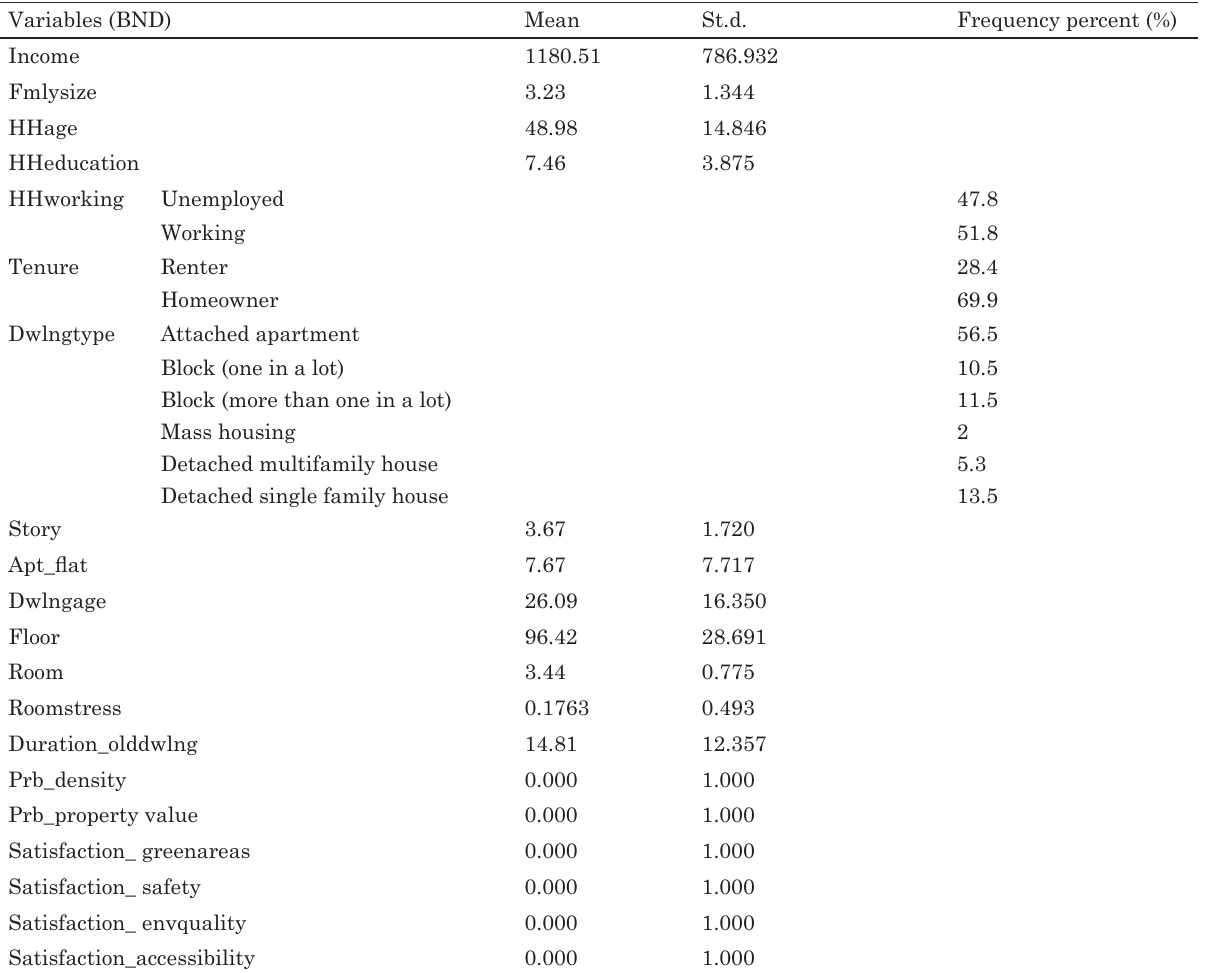
Table 3. The descriptive statistics